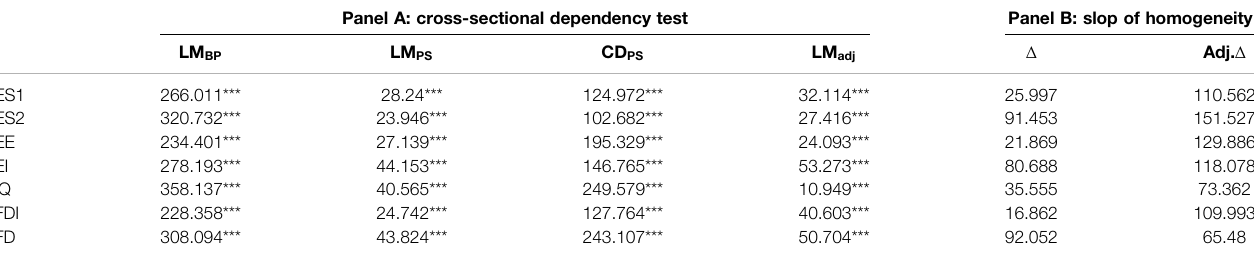
TABLE 3 | Cross-sectional dependency and homogeneity test. Panel A: cross-sectional dependency test Panel B: slop of